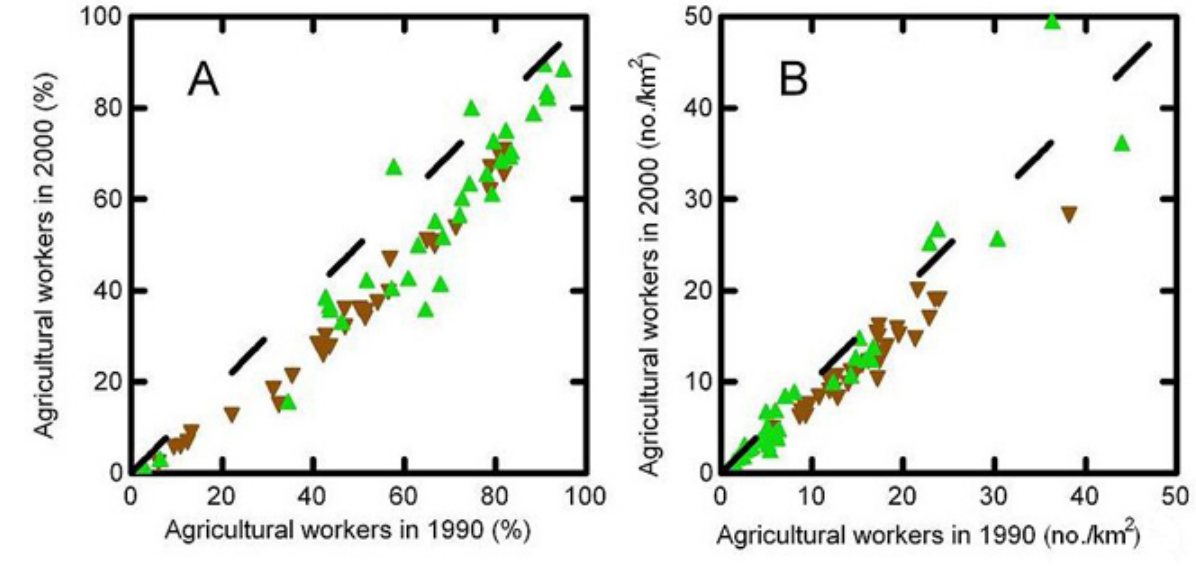
Fig. 4. The relationship between populations engaged in agriculture in 1990 and 2000 (A) as a percentage of the total population and (B) as absolute density for districts of Panama. The dashed line indicates a 1:1 relation. Agricultural workers declined as a percentage of the population in 70 of 74 districts. The absolute density of agricultural workers declined in all districts that were largely deforested before 1947 (brown downward-pointing triangles) and tended to remain unchanged in districts that were first deforested after 1947 (green upward-pointing